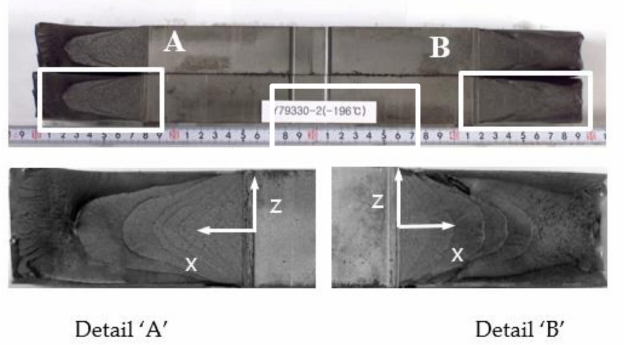
Figure 11. Appearance of fracture in wide plate test specimen (33 mm